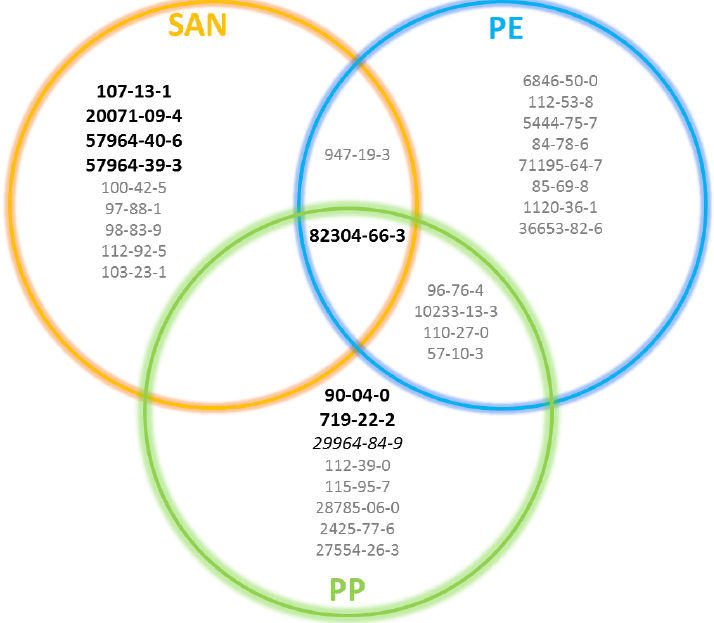
Figure 5. Cartography of the identified compounds to study by packaging materials. Cramer class III compounds are in black and bold, Cramer class II compounds in black and italic, and Cramer class I compounds in grey.